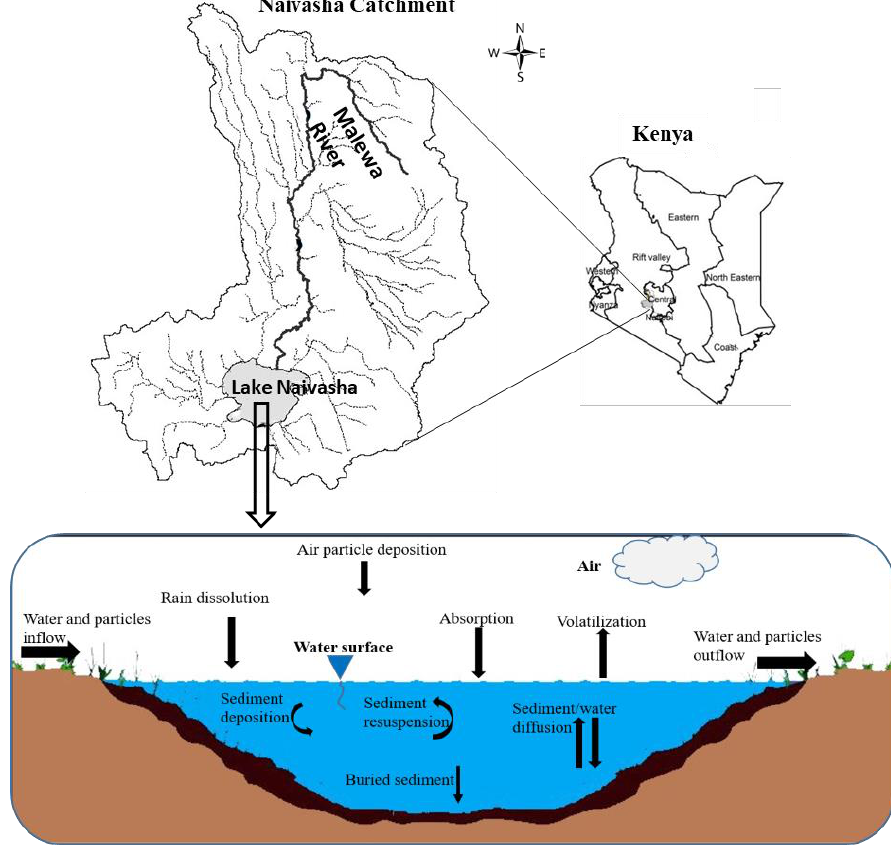
Figure 1. Schematic profile of the lake Naivasha and representation of the QWASI model (reproduced partly from Whelan (2013) [28]) for different environmental compartments.